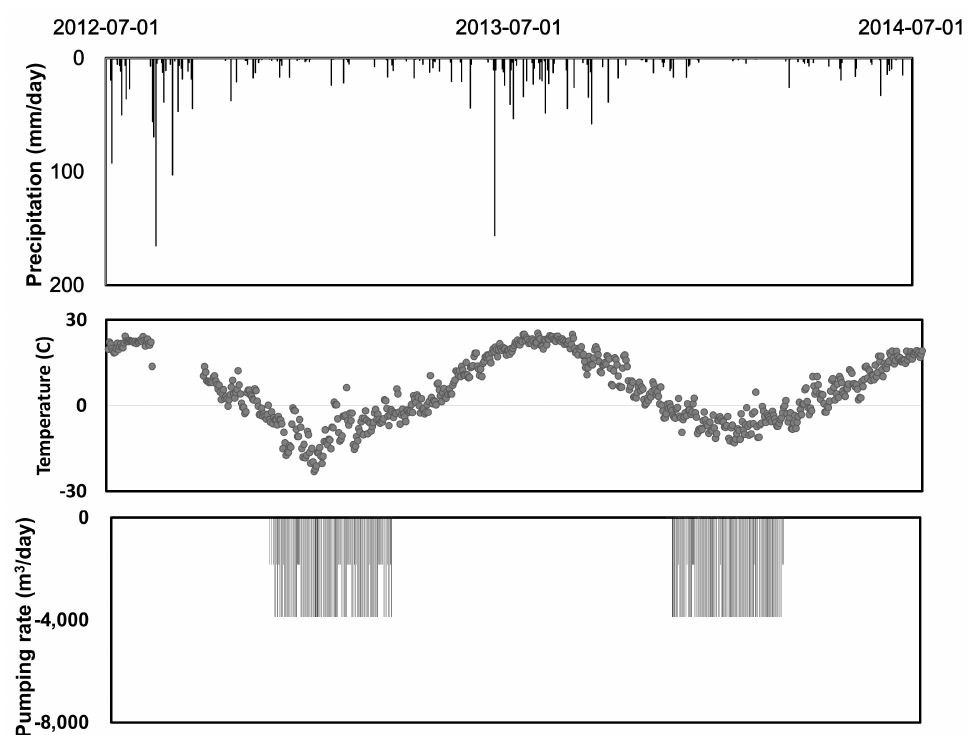
Figure 3. Precipitation, temperature, and the estimated total pumping rate from July 2012 to July